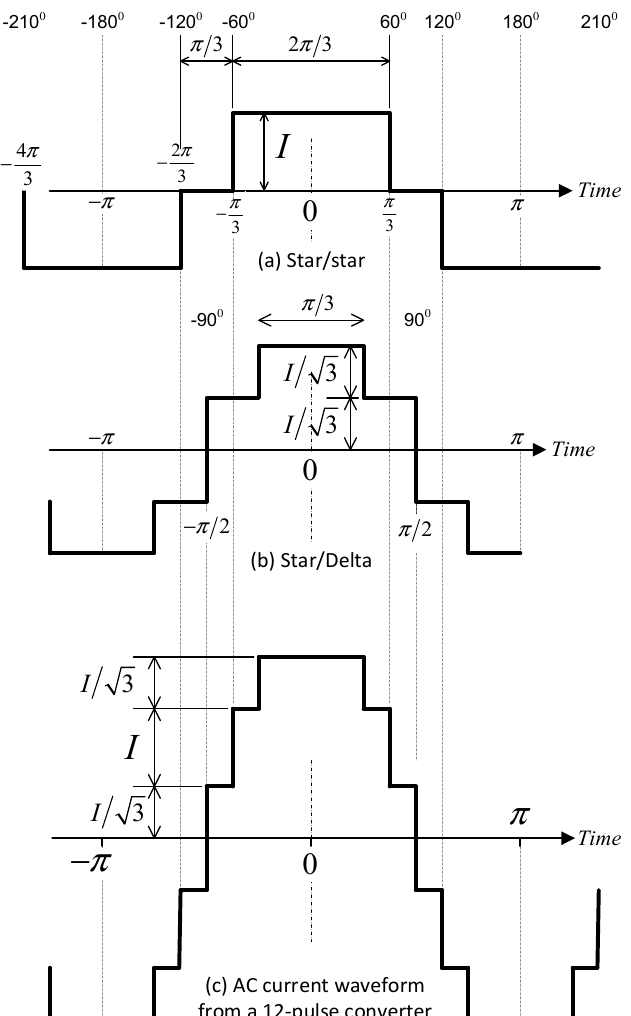
Figure 12. AC Current Waveforms of two 6-pulse bridges and the 12-pulse converter formed from the two: ( a ) AC current from Star/Star connected bridge; ( b ) AC current from Star/Delta connected bridge; ( c ) AC Current from the combination.